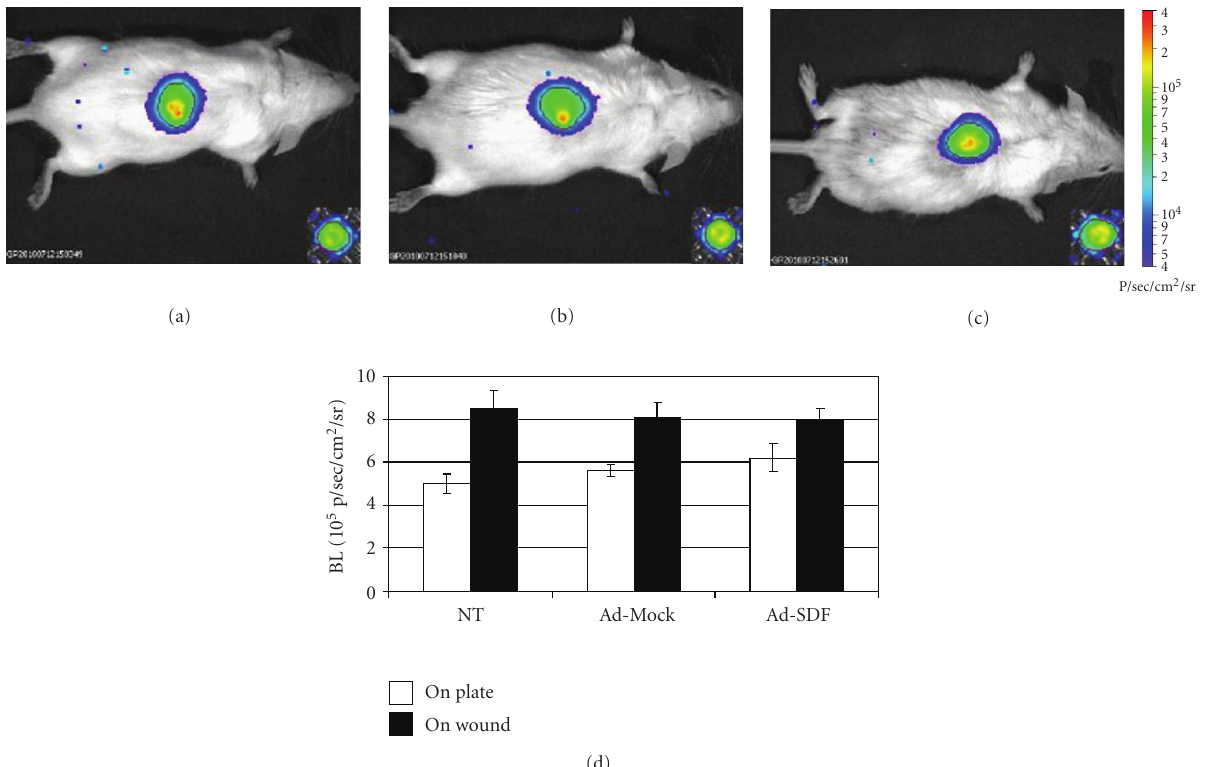
Figure 5: Ex vivo and in vivo imaging of AT-SCs expressing luciferase at time 0. Freshly isolated AT-SCs from luciferase-expressing mice were subjected to adenoviral-mediated gene transfer ((a) non-transduced; (b) Ad-mock-transduced; (c) SDF-1-transduced cells). The AT-SCs were placed in a 96-well cell culture plate and BLI imaging was performed (insert of each figure panel). The same cells were then administered to hyperglycemic mice right after performing a dorsal lesion and BLI was repeated. Panel (d) shows quantification of the signals. Note. The diameter of a well of a 96-well plate is 6.4 mm; the diameter of the biopsy punch used to induce wounding is 3.5 mm. Data are expressed as mean ± SEM indicated by error bars; n = 3 for each group.